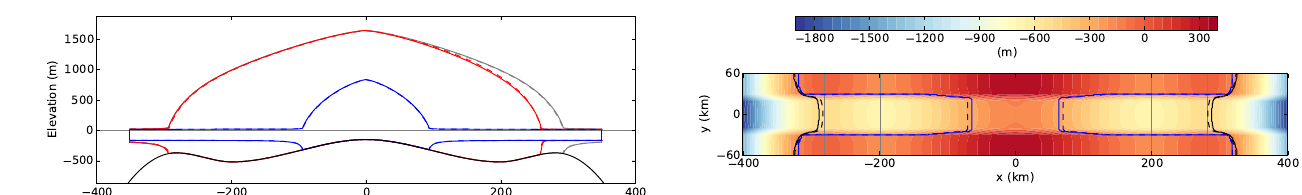
Figure 2. Ice-sheet profiles at three different stages of the flow-line simulations 2-D (continuous) and 2-D ref (dashed). α = 1 ,β = 1 ,γ = 1 2 2 Initial steady-state before perturbation in grey; profile at the end of perturbation in red and final steady-state in blue. Output of the reference simulation is scaled by factor 0.5 in both horizontal and vertical direction to allow for comparison of shapes between the two simulations.